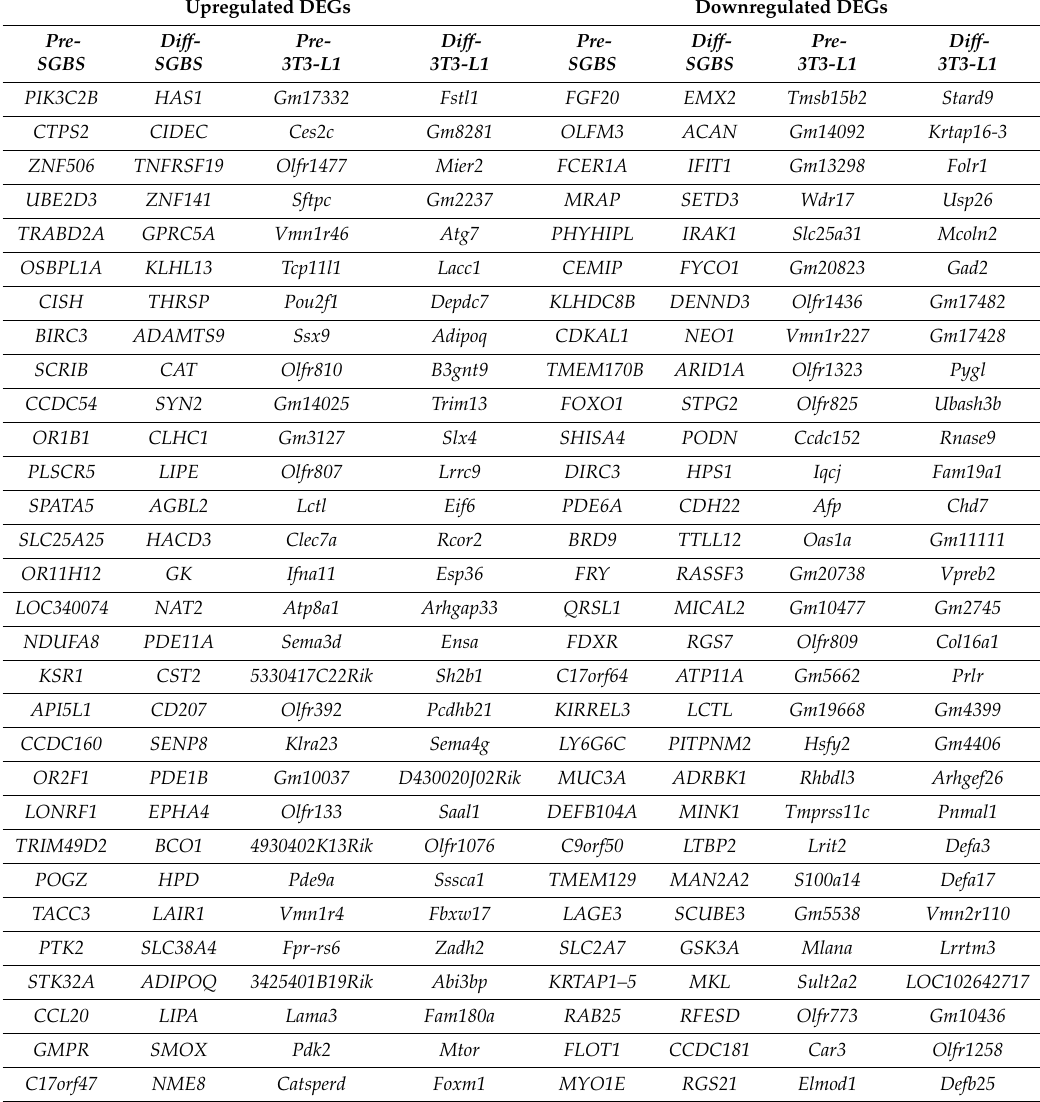
Table 1. The top 30 up- and downregulated DEGs in pre- and di ff erentiated SGBS and 3T3-L1 adipocytes. Upregulated